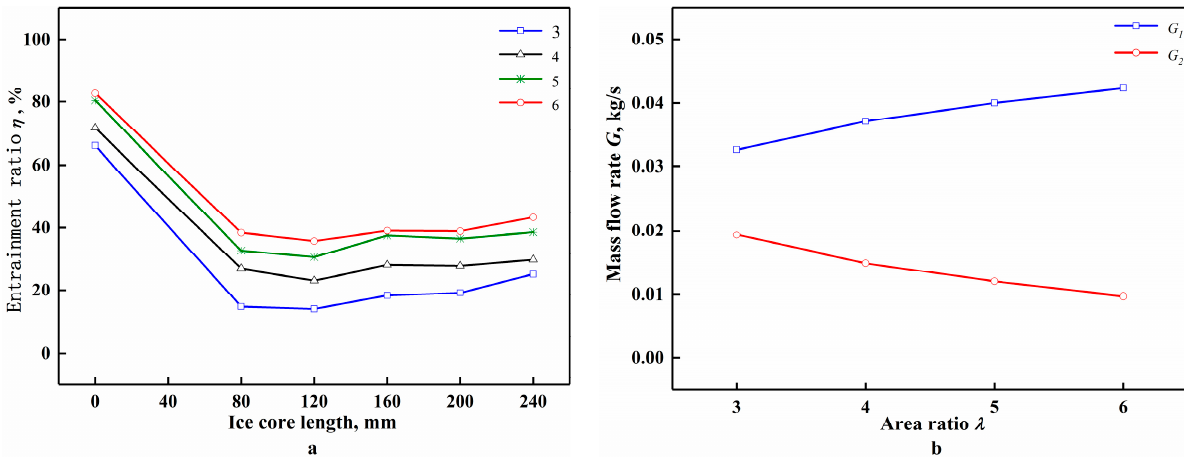
Figure 10. Drill bits with the flushing nozzles: ( a ) influence of area ratio on entrainment ratio; ( b ) distribution of gas mass flow.